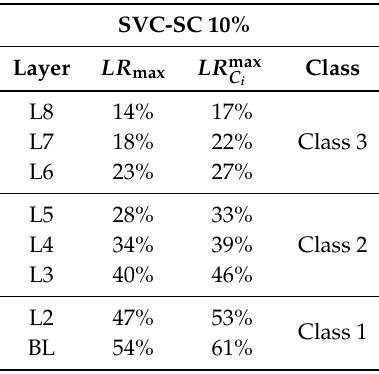
Table A2. Based on initial loss rate, maximum Loss Rate LR max and LR max and per class, for a 10% packet loss